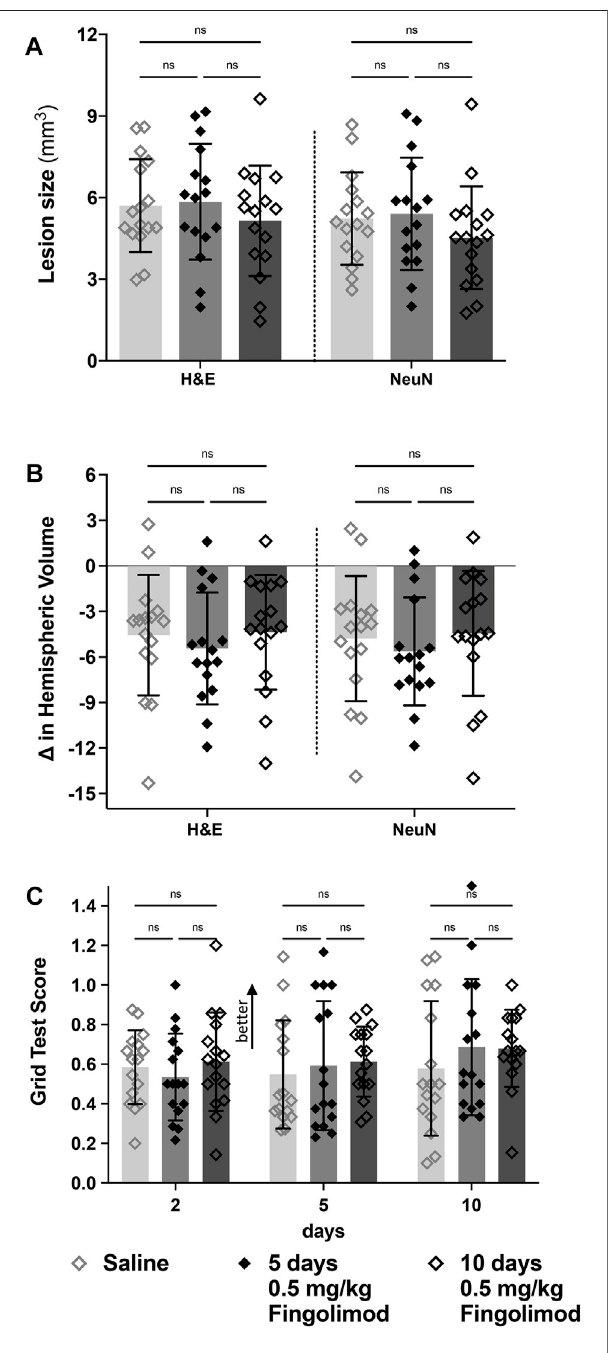
FIGURE 5 | Treatment duration study — (A) Lesion size measurements, by staining method; there was no difference in the lesion size between saline, 5- and 10-days of fi ngolimod treatment. (B) Difference in volume between brain hemispheres; there was no difference in the hemispheric volumes between treatment groups. (C) Grid walking test scores (scores closer to 1 represent a more comparable number of missed steps on each side); there was no difference over time or between treatment groups ◇ Saline ( n = 16) ◆ 0.5 mg/kg fi ngolimod for 5 days ( n = 16) ◇ 0.5 mg/kg fi ngolimod for 10 days ( n =16). Mean ±SD; ns-not signi fi cant;* p < 0.05; ** p < 0.005; *** p < 0.0005.